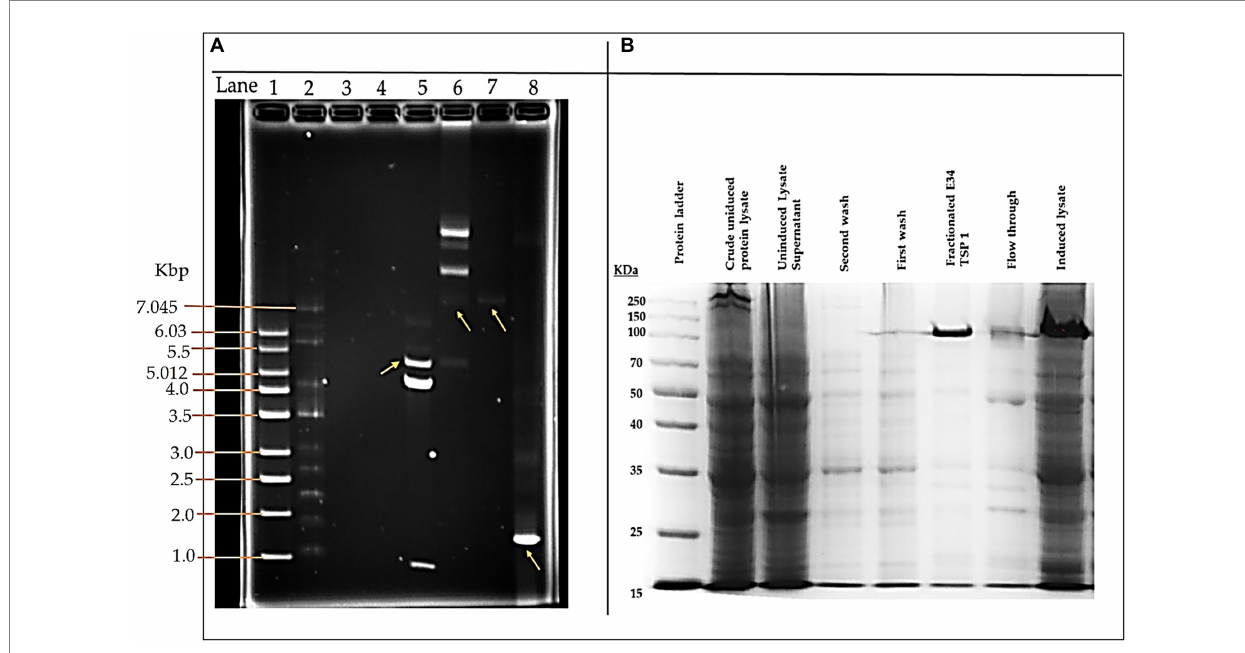
FIGURE 1 pET30a-LIC-E34 TSP clone verification and E34 TSP protein purification analysis. (A) Analysis of pET30a-E34 TSP clone in a 0.8% agarose gel. (B) Analysis of E34 TSP lysate and fraction using 10% SDS PAGE. Lane 1 = 1 kb DNA ladder, from Millipore Sigma. Lane 2 = NEB supercoil ladder;